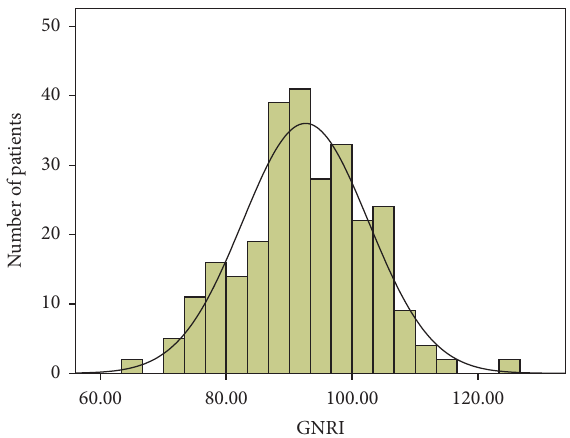
Figure 1: Distribution of geriatric nutritional risk index